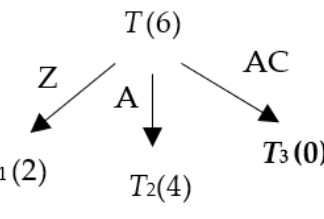
Figure 5. Search Tree for Greedy Approach.